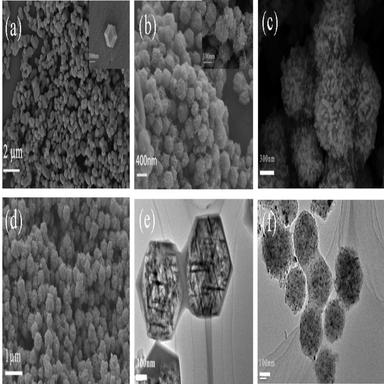
SEM patterns of ZIF-67 @ZIF-8 (a) and Co-NC (b), NiS (c), NiS@Co-NC (d); TEM images of ZIF-67 @ZIF-8 (e) and Co-NC (f).